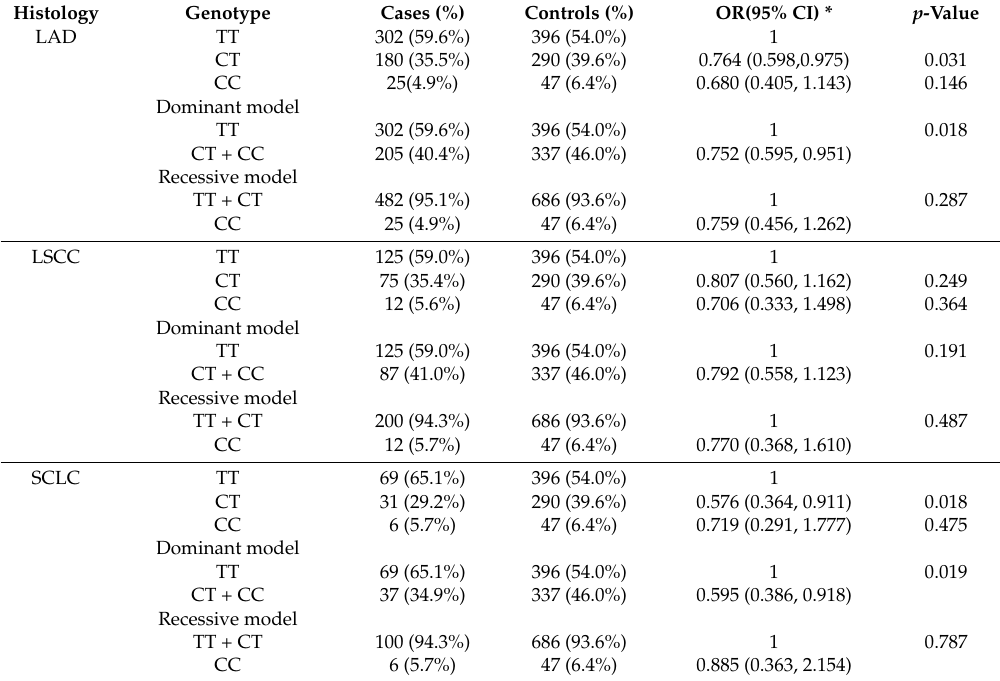
Table 3. Stratification analysis of rs1412125 polymorphisms and risk of lung